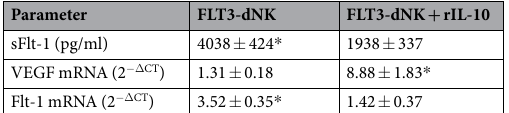
Table 1. IL-10 contributes to the angiogenesis process associated with early gestation when NK cells are temporarily depleted. Data are means ± SEM (n = 6–8/group). Serum sFlt-1 levels are shown as mean values analyzed by ELISA on ED7.5 and decidual VEGF and Flt-1 expression on ED7.5, as analysed by qPCR. * p < 0.05 , using two-tailed t-